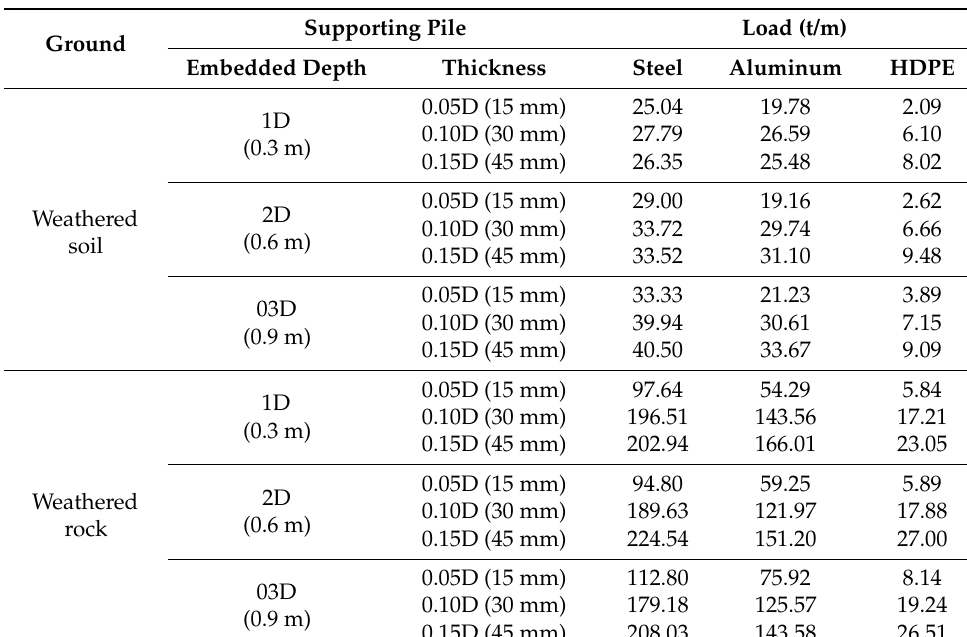
Figure 24. The maximum load with embedded depth in ( a ) weathered soil and ( b ) rock. Table 3. Allowable load of